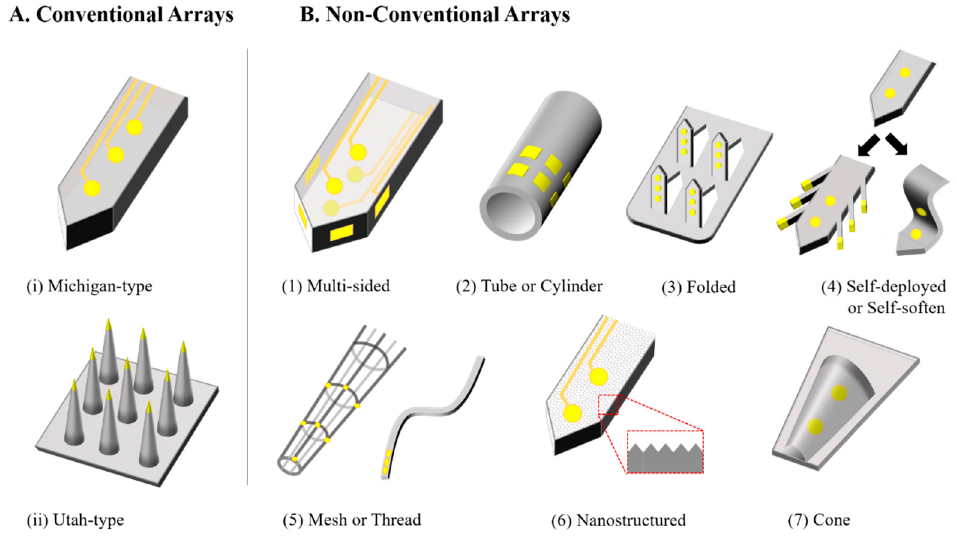
Figure 1. ( A ) Conventional microelectrode arrays including Michigan and Utah probes; ( B ) non-conventional microelectrode arrays with multi-sided, tubular, cylindrical, folded, self-deployable, self-softening, mesh, thread, nanostructured, or conical shape